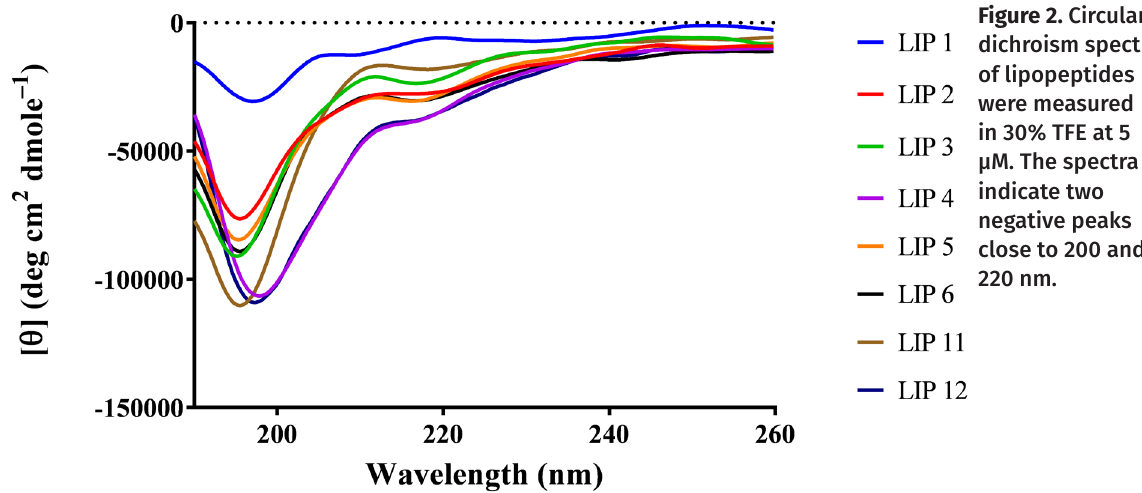
Figure 2. Circular dichroism spectra of lipopeptides were measured in 30% TFE at 5 μM. The spectra indicate two negative peaks close to 200 and 220